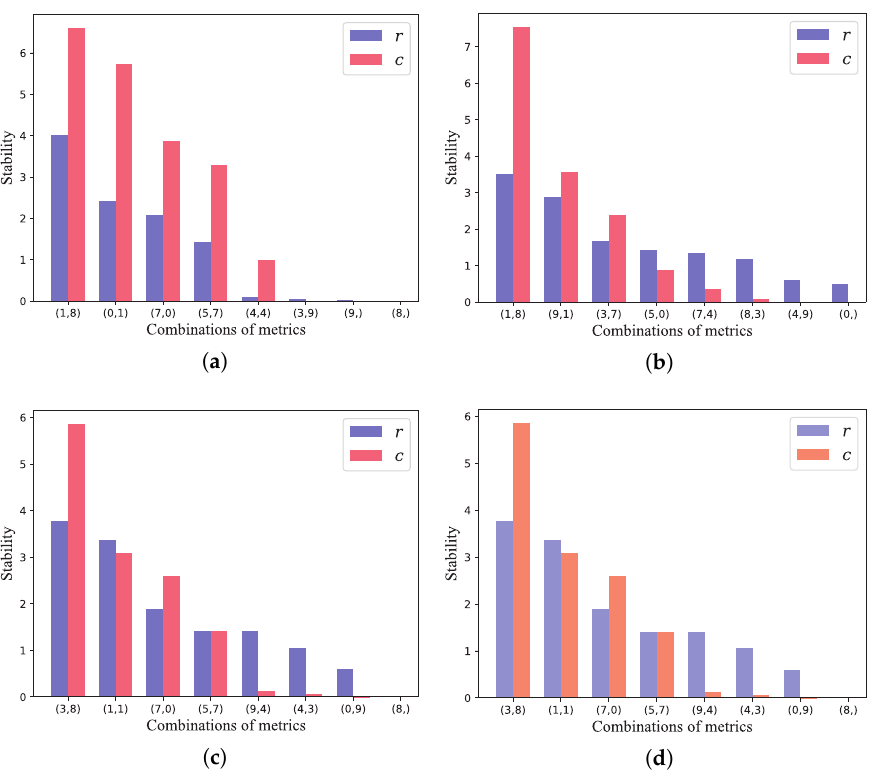
Figure 6. The most stable metric combinations for precision. ( a ) State. ( b ) Tri-state. ( c ) IFS-tri-state. ( d ) RFS-tri-state.